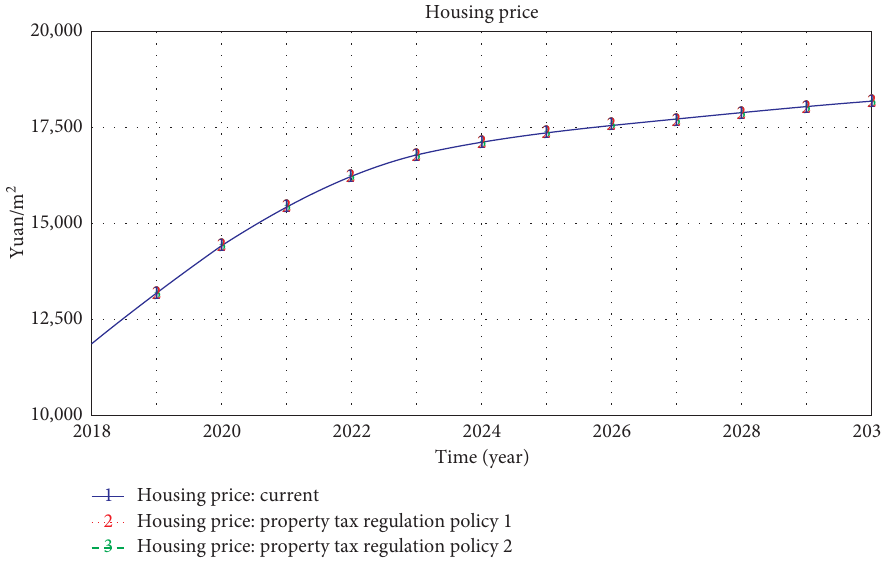
Figure 14: Influence of property tax policy regulation on housing price.